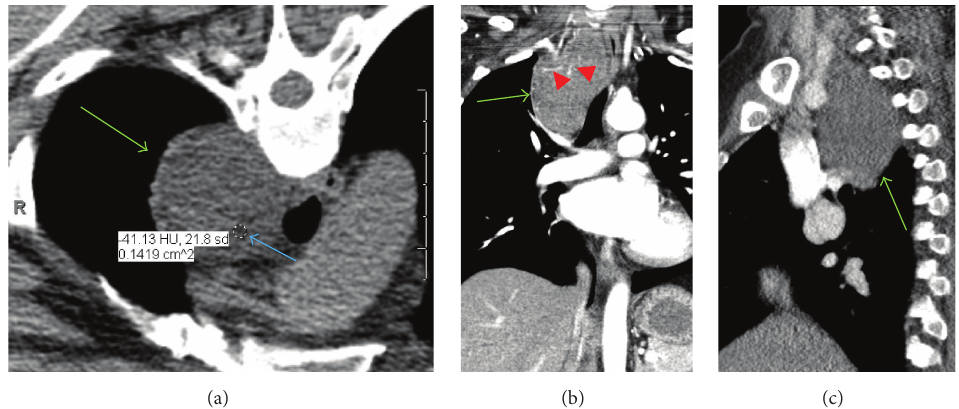
Figure2:ContrastenhancedaxialCT(a)withcoronal(b)andsagittal(c)CTreconstructionsofthechestdemonstratingawellcircumscribed, heterogeneously enhancing mass (green arrows) with areas of fat attenuation (blue arrow pointing to ROI in (a)) and a few mildly prominent internal vessels (red arrow heads in (b)) within the superior, posterior right mediastinum.